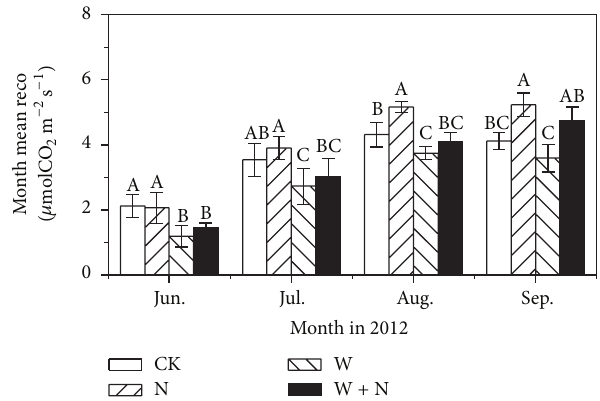
Figure 3: Monthly mean soil respiration over growing season under different treatments in alpine meadow in 2012. See Figure 2 for the abbreviations of